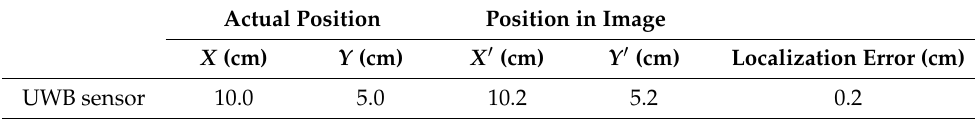
Table 1. Tumor localization